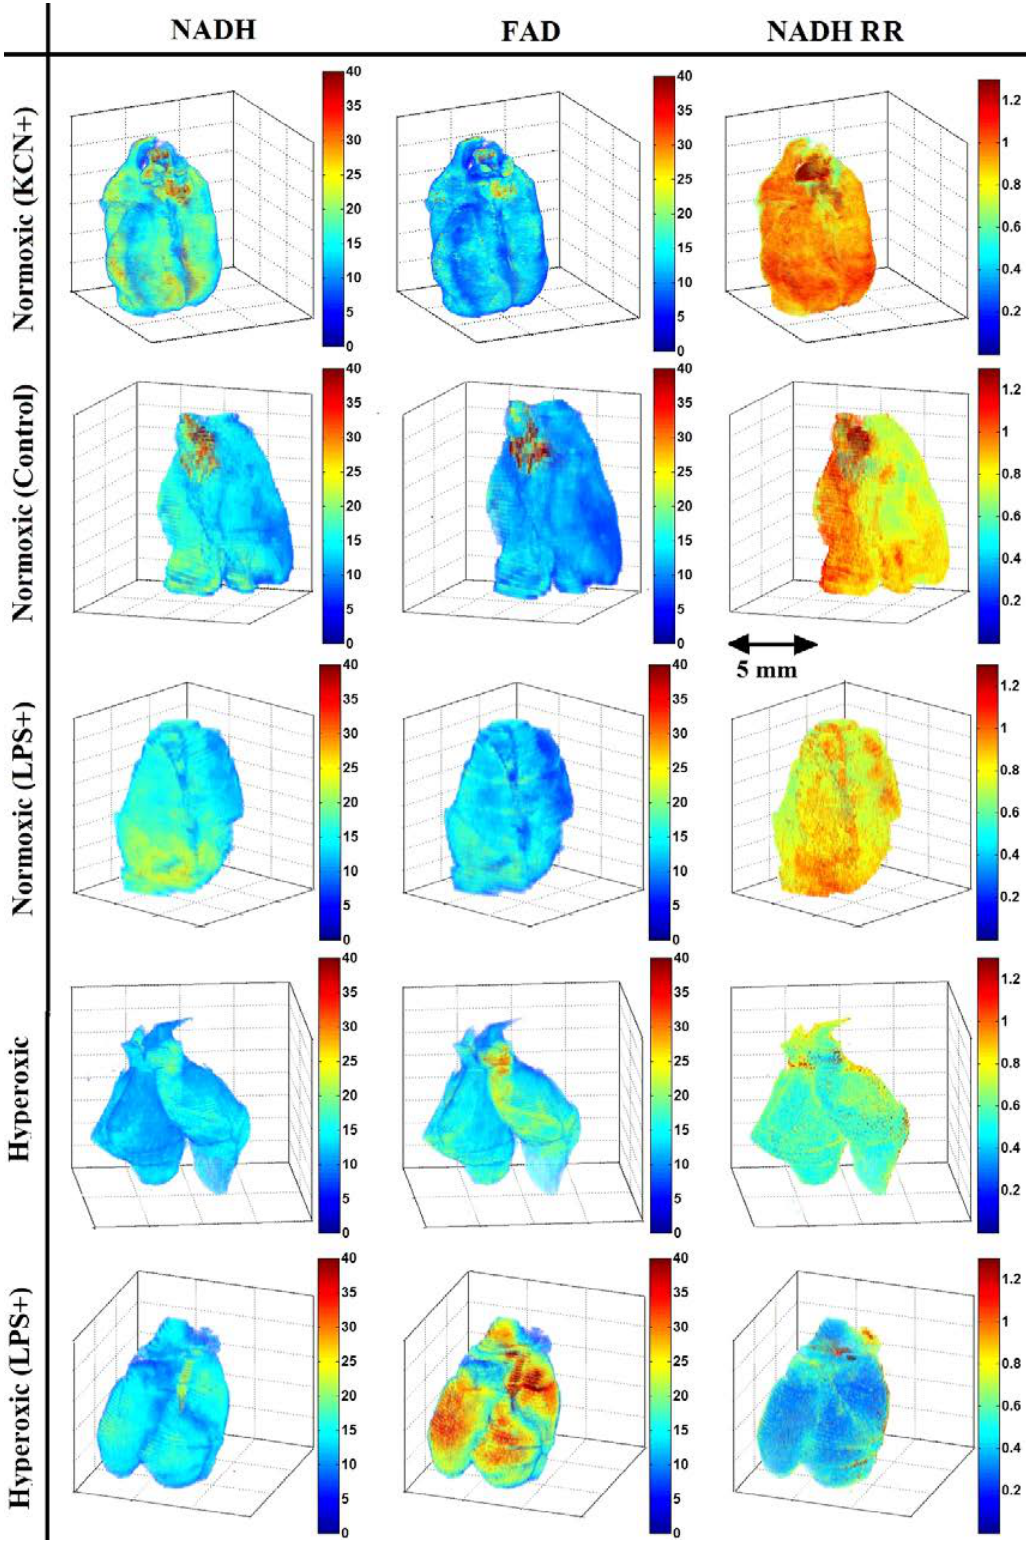
Fig. 2. Volume rendering of NADH, FAD and NADH redox of a representative lung in each